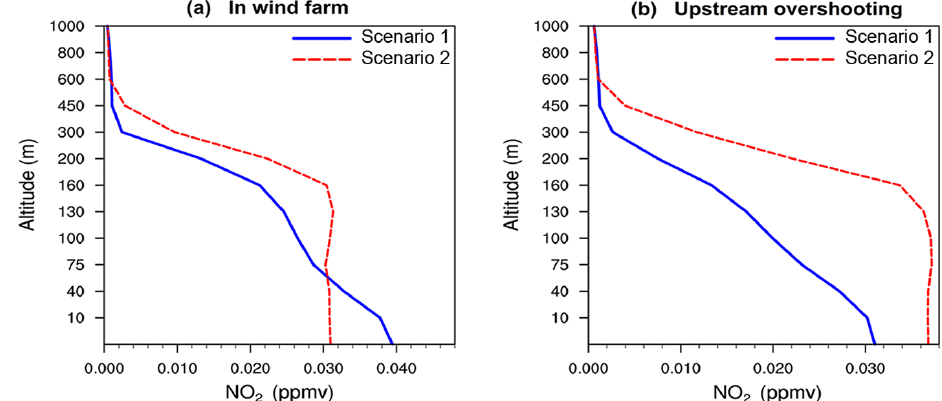
Figure 9. Vertical profiles of NO 2 concentrations at two model grids at (a) (44, 52) at 21:00UTC on 19 November within the YWF and (b) (44, 48) at 22:00UTC on 19 November in the upstream of the YWF, simulated by the control run (S1, blue solid line) and S2 run accounting for the roughness changes in the wind farm (red dashed line).